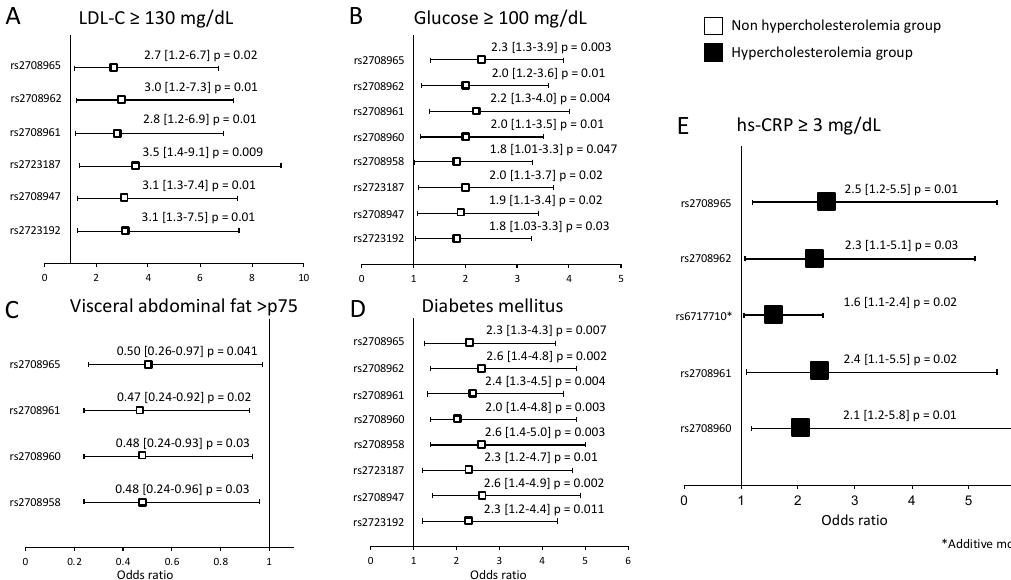
Figure 2. Association of the polymorphisms with metabolic variants. In individuals without HC, six polymorphisms were associated with LDL-C ≥ 130 mg / dL ( A ), eight polymorphisms were associated with glucose ≥ 100 mg / dL ( B ), four polymorphisms were associated with visceral abdominal fat > p75 ( C ), and eight polymorphisms were associated with a high risk of T2DM ( D ). In individuals with HC, five polymorphisms were associated with hs-CRP ≥ 3 mg / dL ( E ). hs-CRP: high sensitive C-reactive protein.